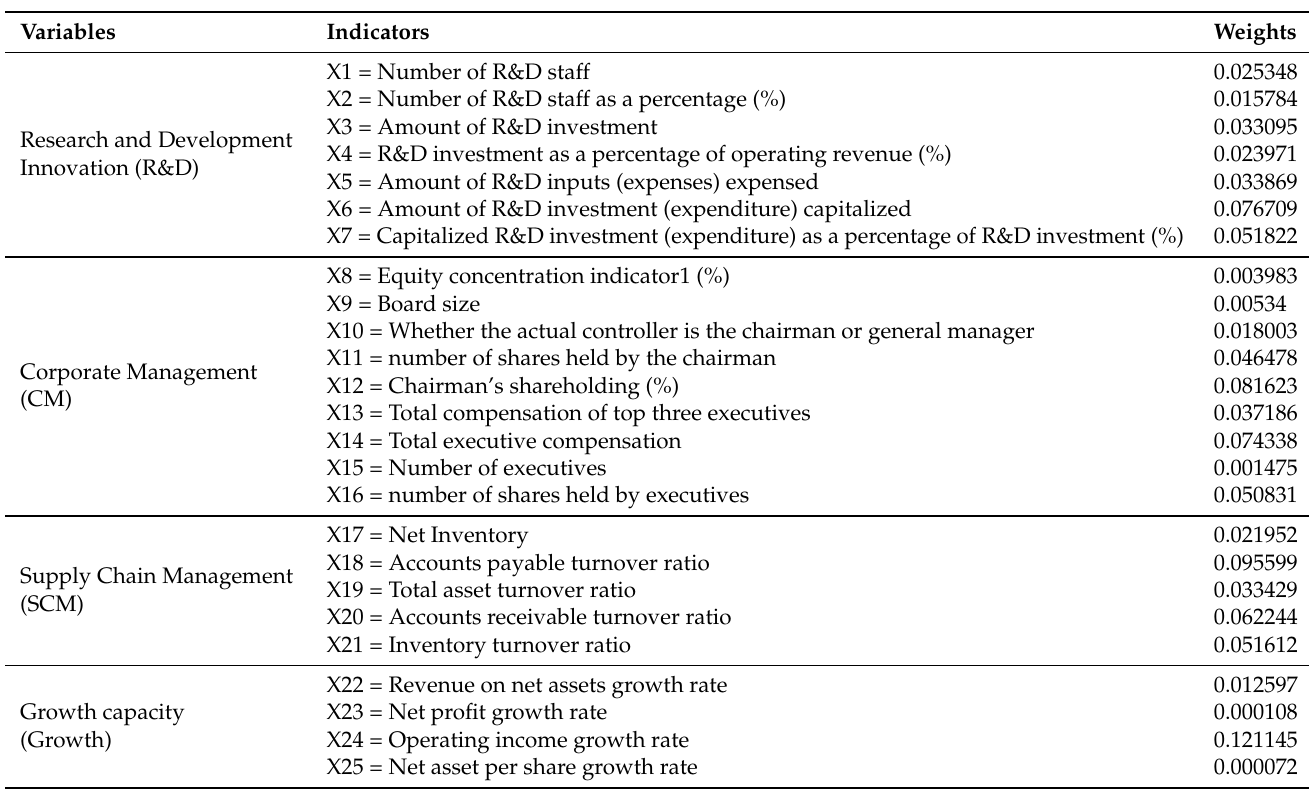
Table 2. Index selection and weight